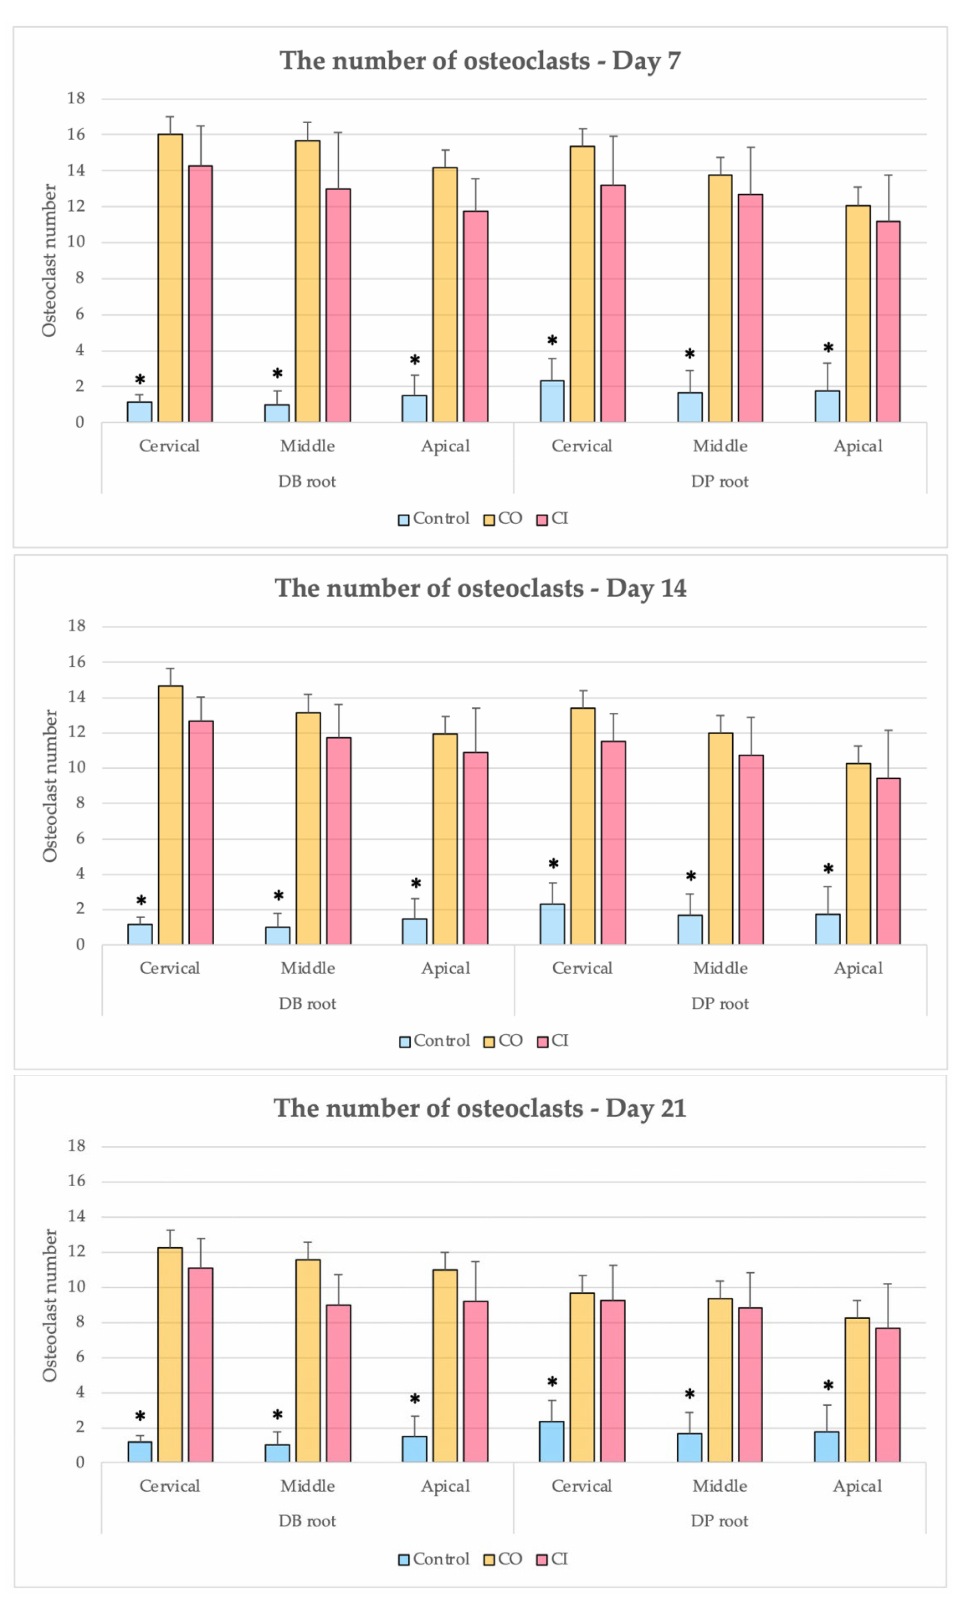
Figure 6. Comparisons between control, CO, and CI groups on days 7, 14, and 21. * p <